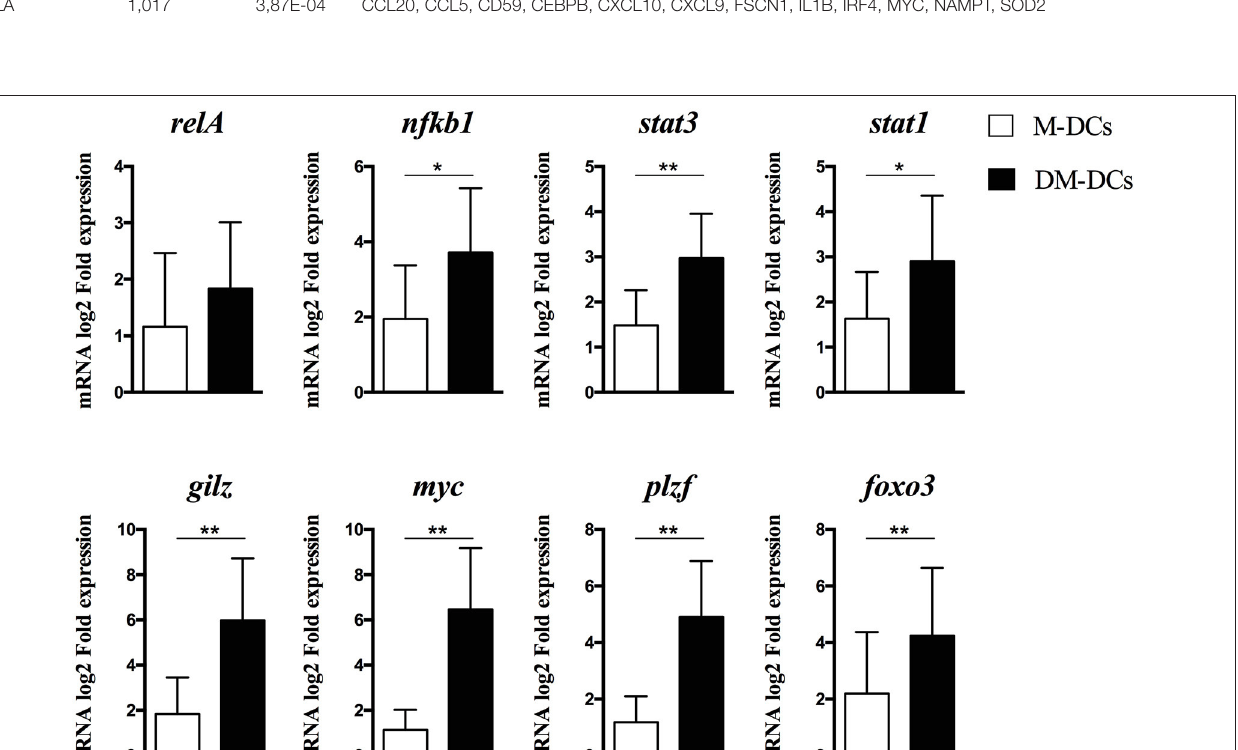
Frontiers in Immunology |